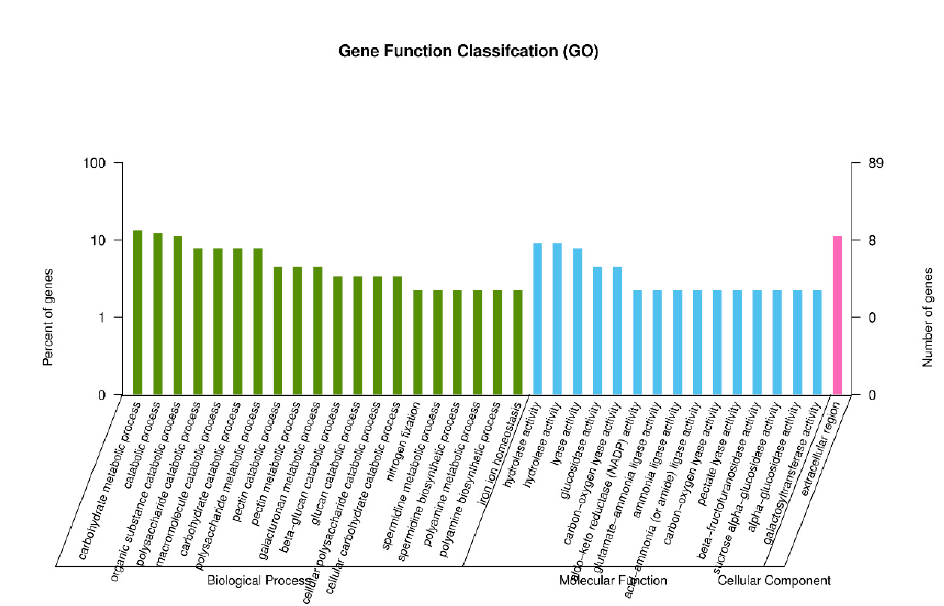
Figure 4. Gene Ontology (GO) classification of differentially expressed genes (DEGs) identified. GO classification of differentially up-regulated genes of VFSP/VCSP ( A ) leaves and ( B ) storage roots. GO classification of differentially down-regulated genes of VFSP/VCSP ( C ) leaves and ( D ) storage roots.